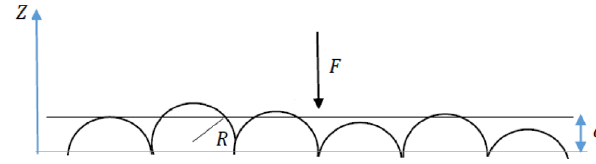
Fig. 1 The schematic drawing of GW model.